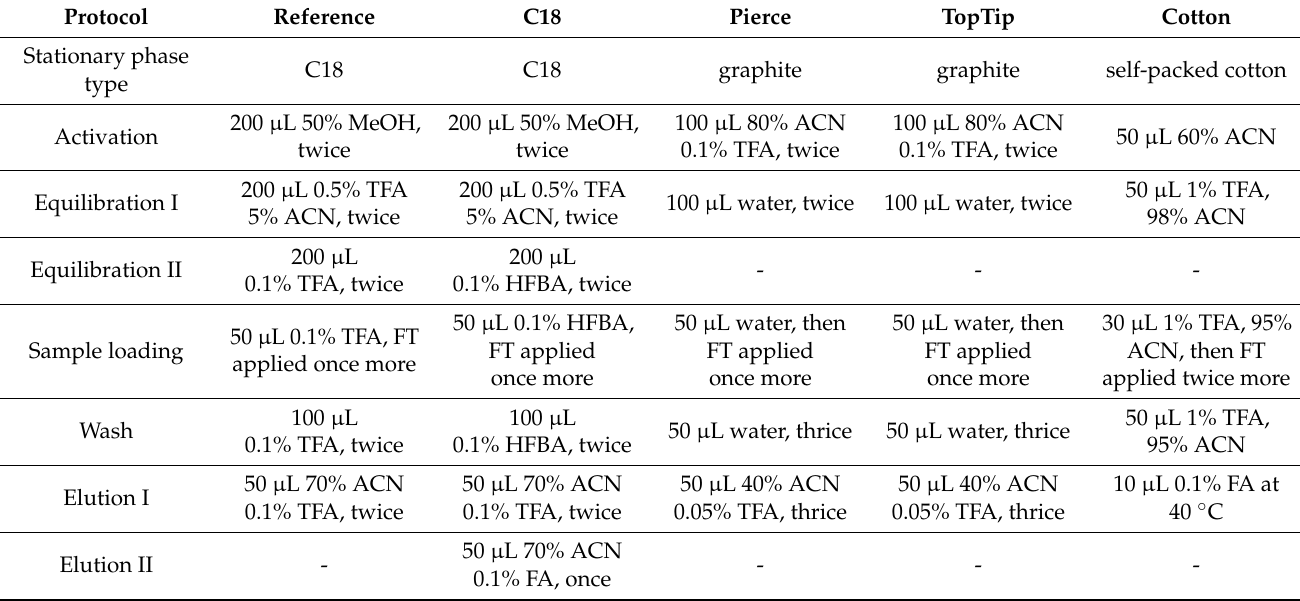
Table 5. Stationary phases and solvent systems used for finding the optimal SPE method for